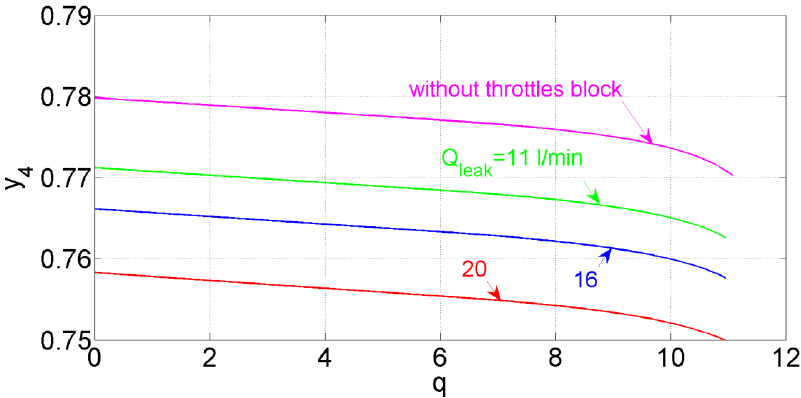
Figure 3. Output pressure y 4 as a function of flow rate q at various leakages Q leak between cavities A and C ( A th 1 = A th 2 = 1.77 mm 2